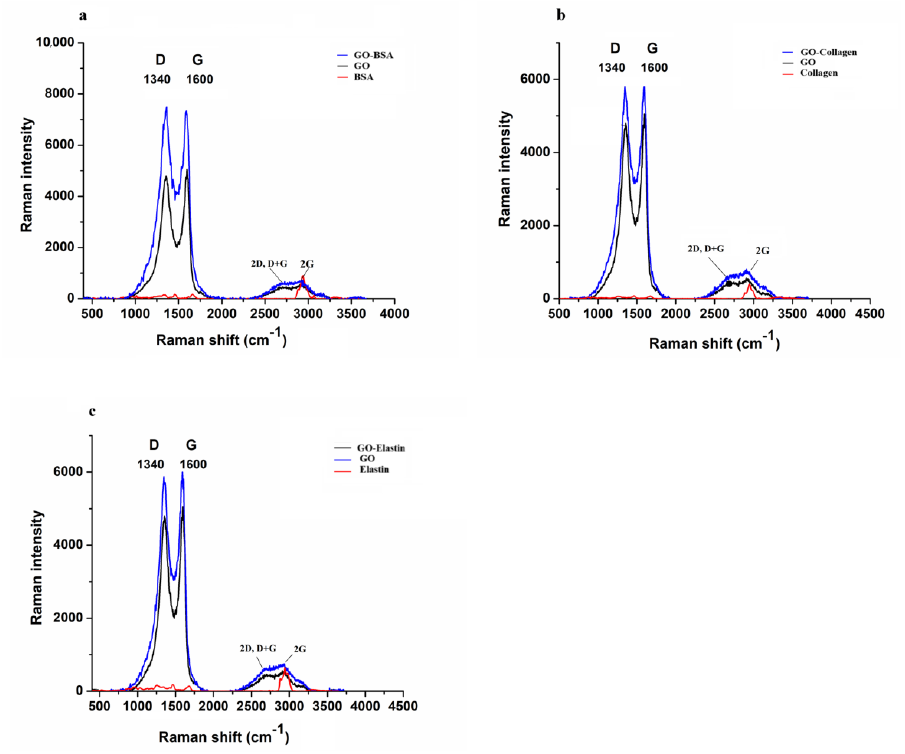
Figure 1. Raman spectrum of GO, BSA ( a ), collagen ( b ) and elastin ( c ), and the combination of each protein with GO.